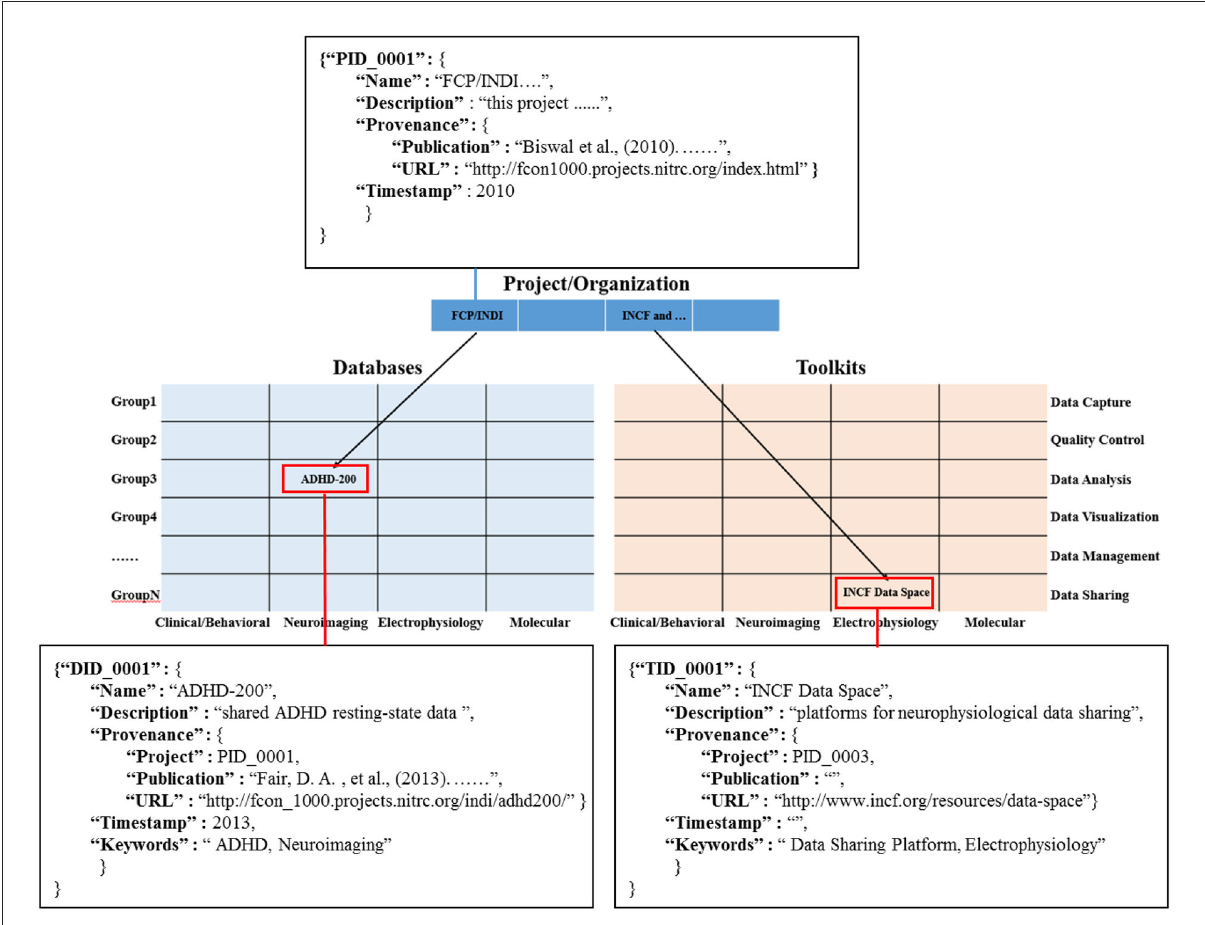
FIGURE4 The information objects in knowledge base are coded and organized by dictionary.